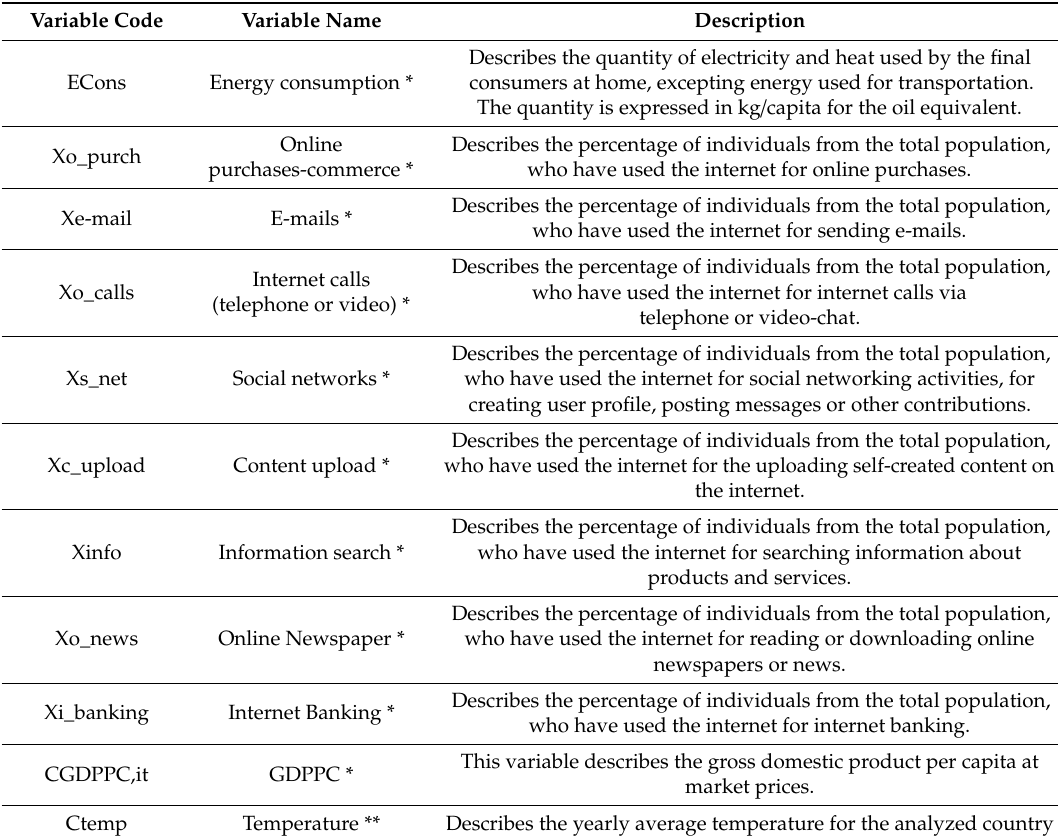
Table 1. Definition of